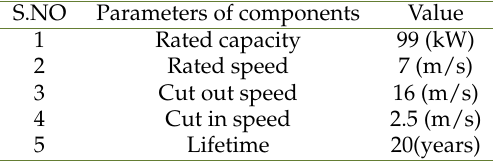
Table 2. Wind energy parameters Table 3. Energy storage parameters